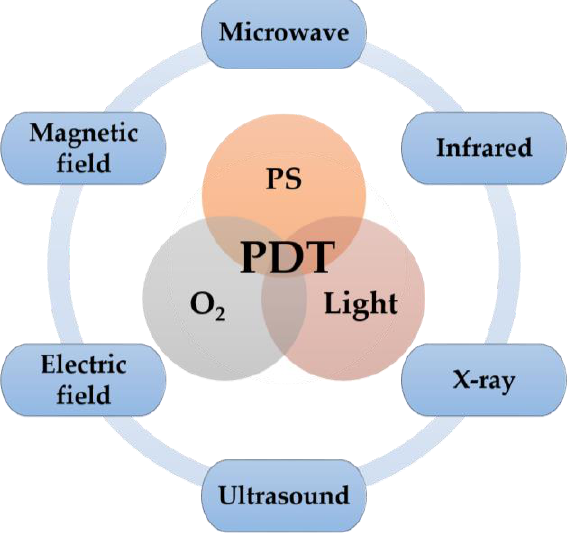
Figure 2. Schematic illustration of other energy sources (in addition to the visible light source) that can be used in PDT to overcome its limitations and enhance its therapeutic effect.